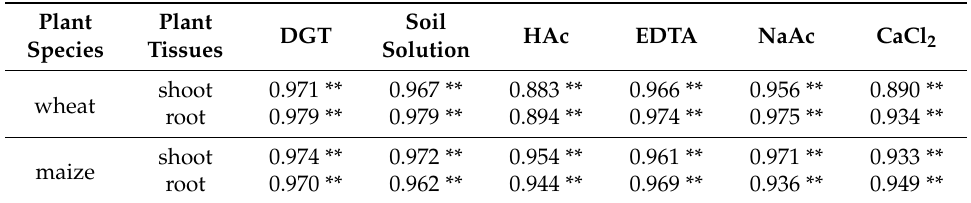
Table 2. The Pearson correlation coefficients ( r ) of the 24 samplers between Cd concentrations in the plant tissues and bioavailable concentrations of Cd measured by six methods.